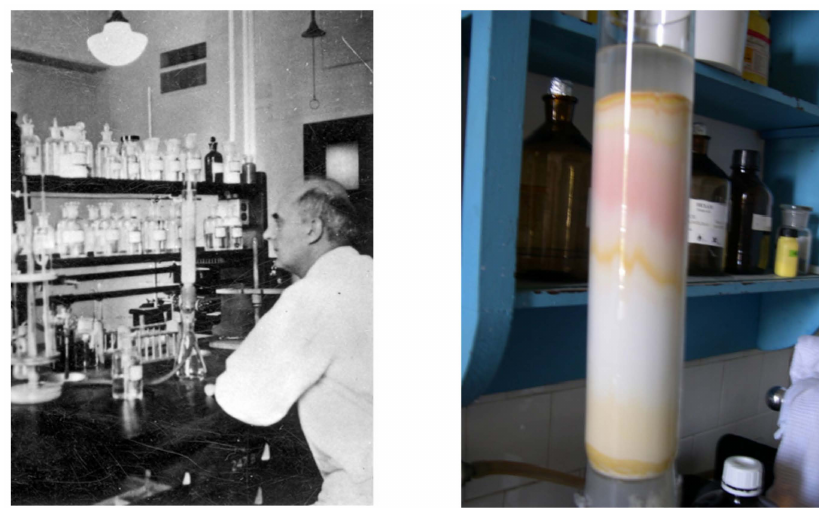
Figure 2. Column chromatography from around 1930 and from the present